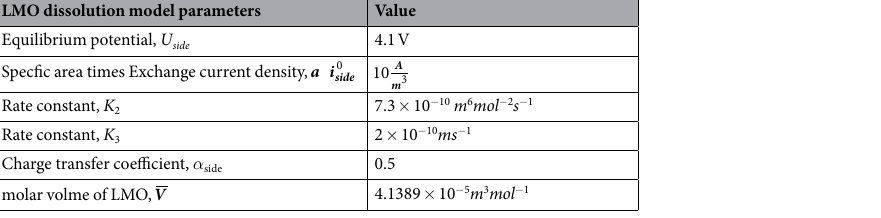
Table 4. Parameters used for the LMO dissolution model.